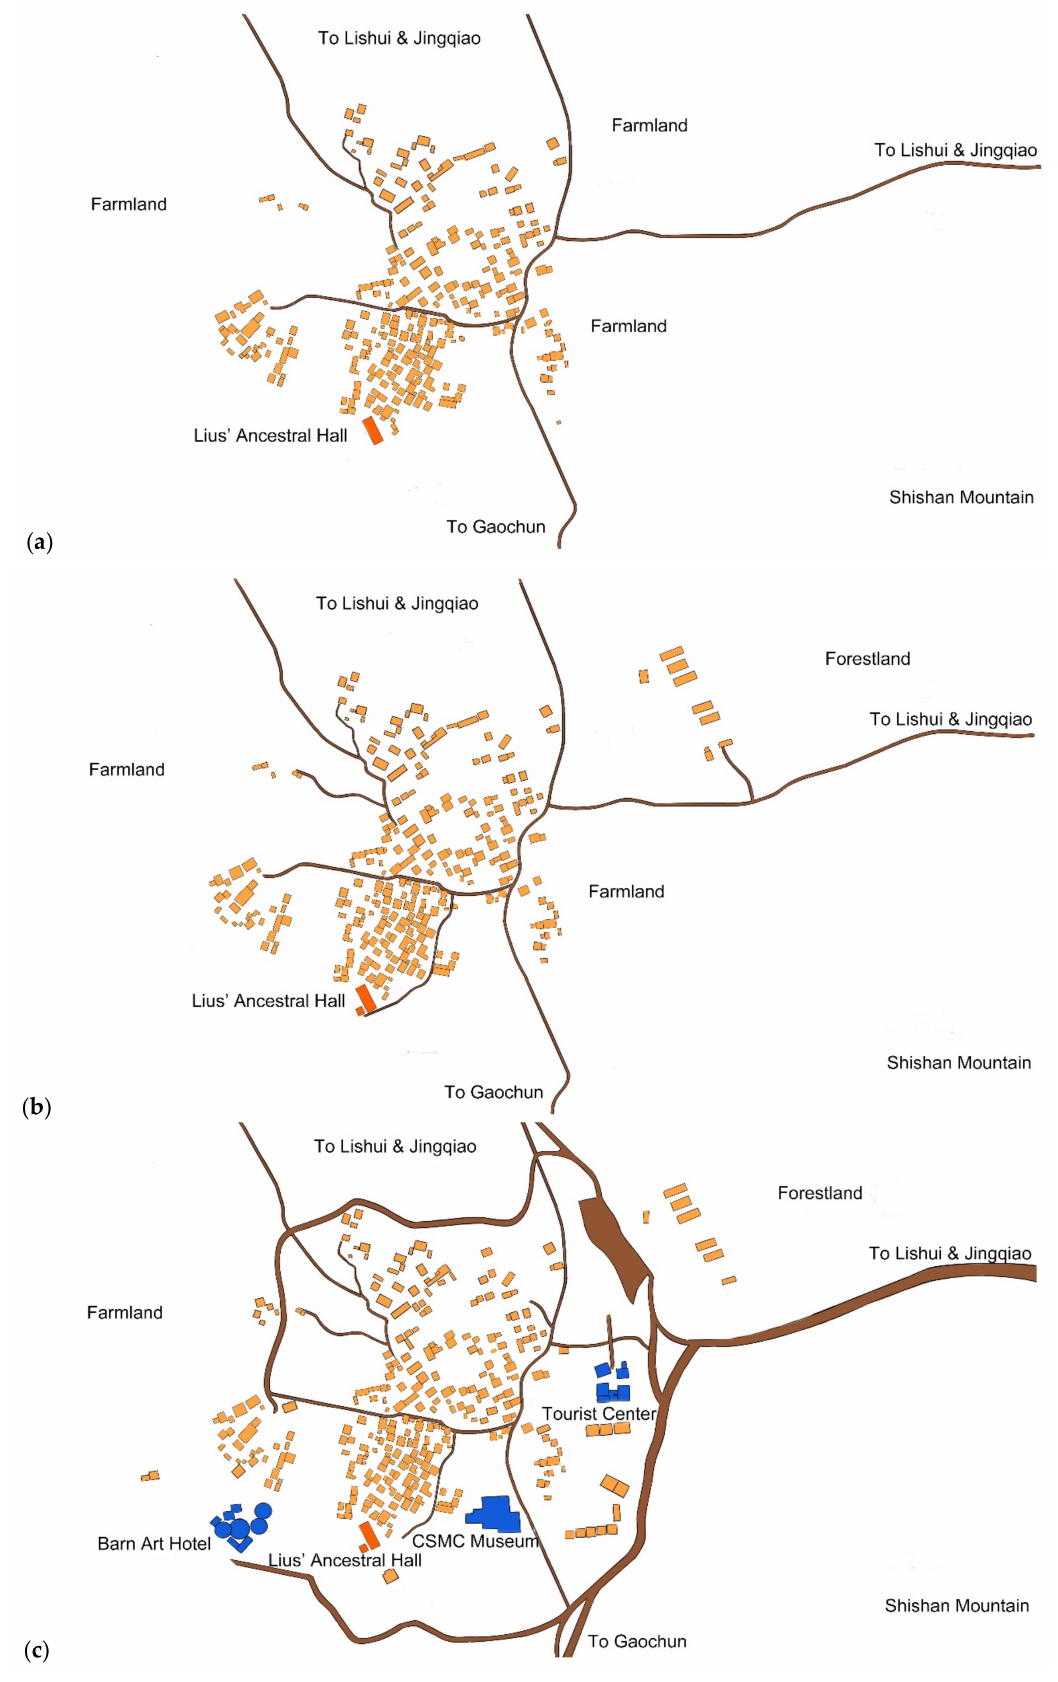
Figure 2. ( a ). Shishanxia, 2014; ( b ) Shishanxia, 2016; ( c ) Shishanxia,